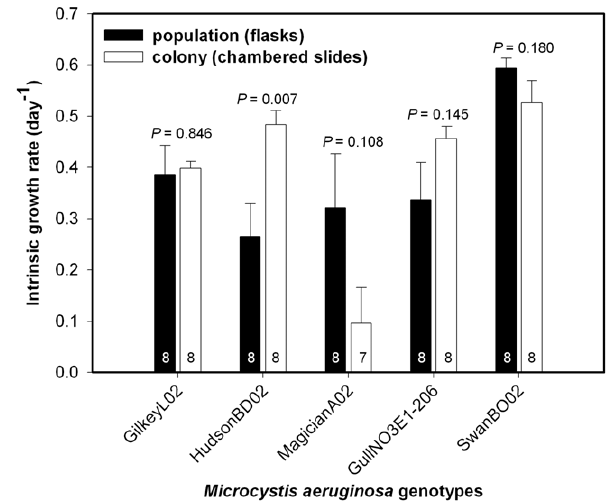
Figure 4. Population and colony growth rate comparison. Growth rates for five Microcystis aeruginosa genotypes (GilkeyL02, HudsonBD02, MagicianA02, GullNO3E1-206, SwanBO02) grown in batch culture (flasks, dark bars) versus individual colonies grown in chambered slides (white bars). Error bars=1 standard error. Inset numbers are sample sizes.